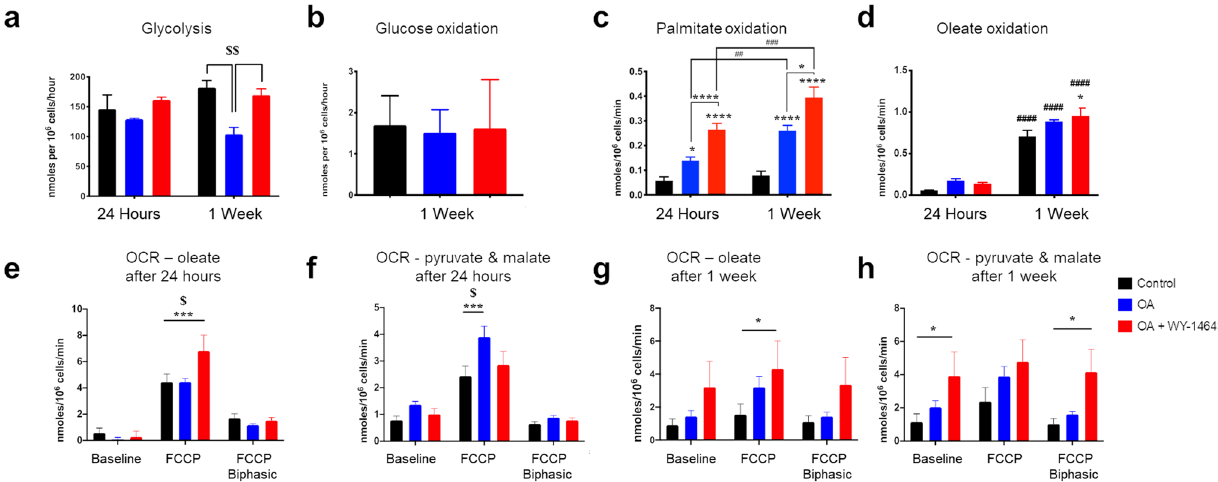
Figure 2. Rates of ( a ) glycolysis (n = 4), and of oxidation of ( b ) glucose (n = 8), ( c ) palmitate (n = 16) and ( d ) oleate (n = 4) were measured in day 12–15 hiPSC-CMs after culture for 24 h or 1 week with OA + / − WY-14643. Cellular oxygen consumption rate (OCR) was measured using the Clark-type oxygen electrode in hiPSC-CMs respiring on oleate ( e , g ) or pyruvate & malate ( f , h ); *,**,***,**** p < 0.05, 0.01, 0.001, 0.0001 compared with control or treated hiPSC-CMs at the same time point as indicated; #, ##, ###, #### p < 0.05, 0.01, 0.001, 0.0001 compared with cells treated for 24 h; $, $$ p < 0.05, 0.01 compared with hiPSC-CMs + OA (n =